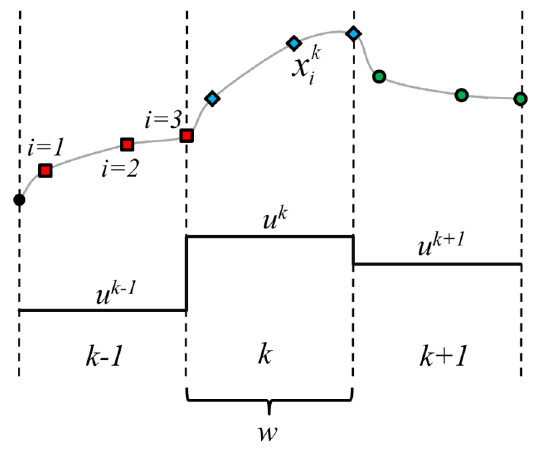
Figure 1. A schematic illustrating the orthogonal collocation on finite elements discretization with a first-order hold assumed for inputs ( u ) in each element ( k ). The differential state variables ( x ) are approximated at each of the collocation points, denoted by i . The points are represented using different shapes and colors, which help distinguish one finite element from